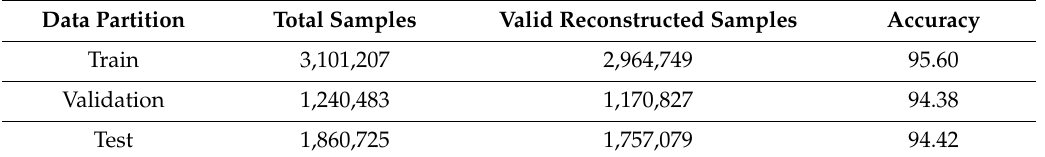
Table 2. Data partitioning of training, validation and test sets, and their